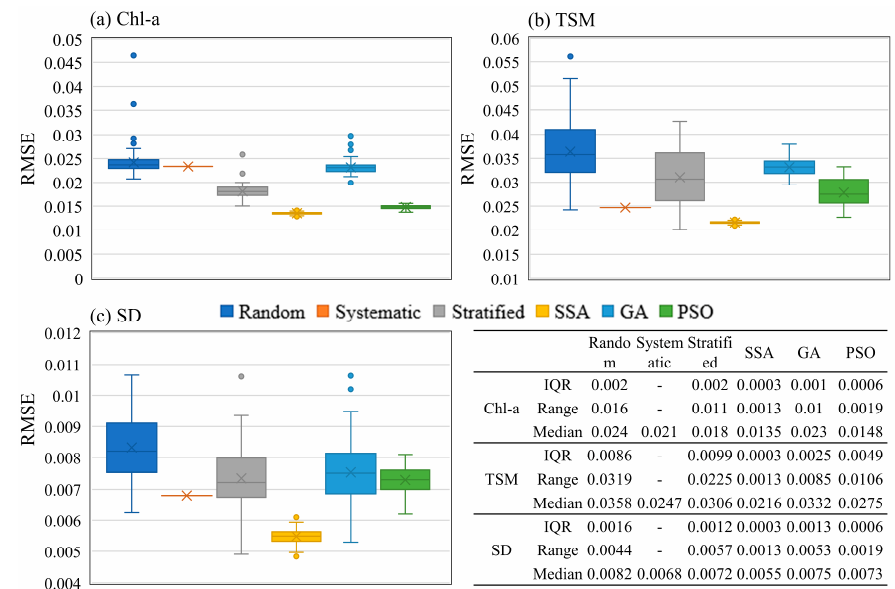
Figure 5. Boxplots of 𝑅𝑃 (cid:3040)(cid:3032)(cid:3028)(cid:3041) for 100 simulations for each sampling method, Chl-a ( a ), TTS ( b ), SD ( c ).